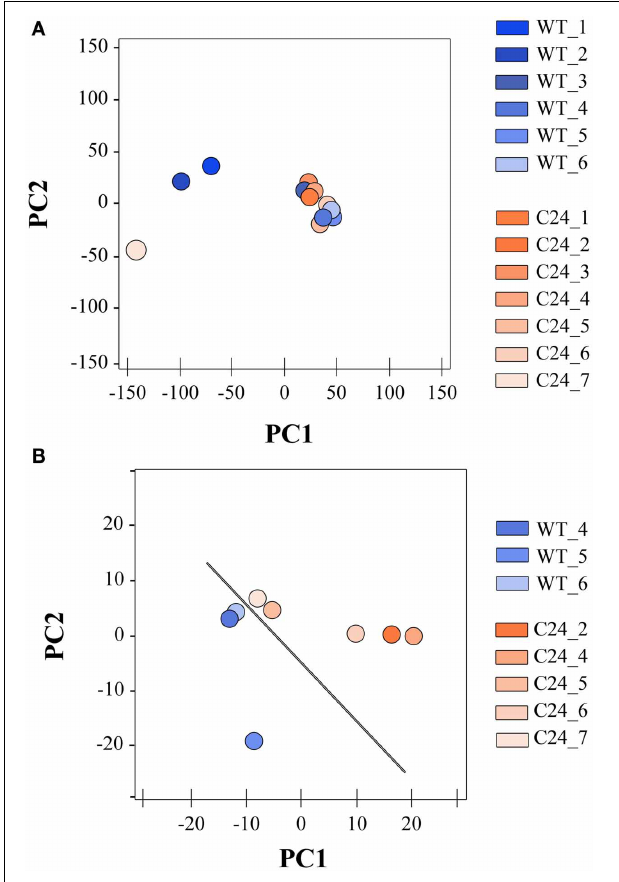
FIGURE 3 | Marker genes allow identification of mRNA-seq libraries displaying significant contamination from neighboring tissues. (A) PCA of global expression trends when including all WT and C24 libraries. (B) Spatial distribution of global expression trends in WT and C24 excluding libraries flagged by the marker gene panel as displaying significant contamination from neighboring tissues. PCA was applied to the stabilized variances estimated from normalized reads counts of ∼ 12,000 genes expressed in WT and C24